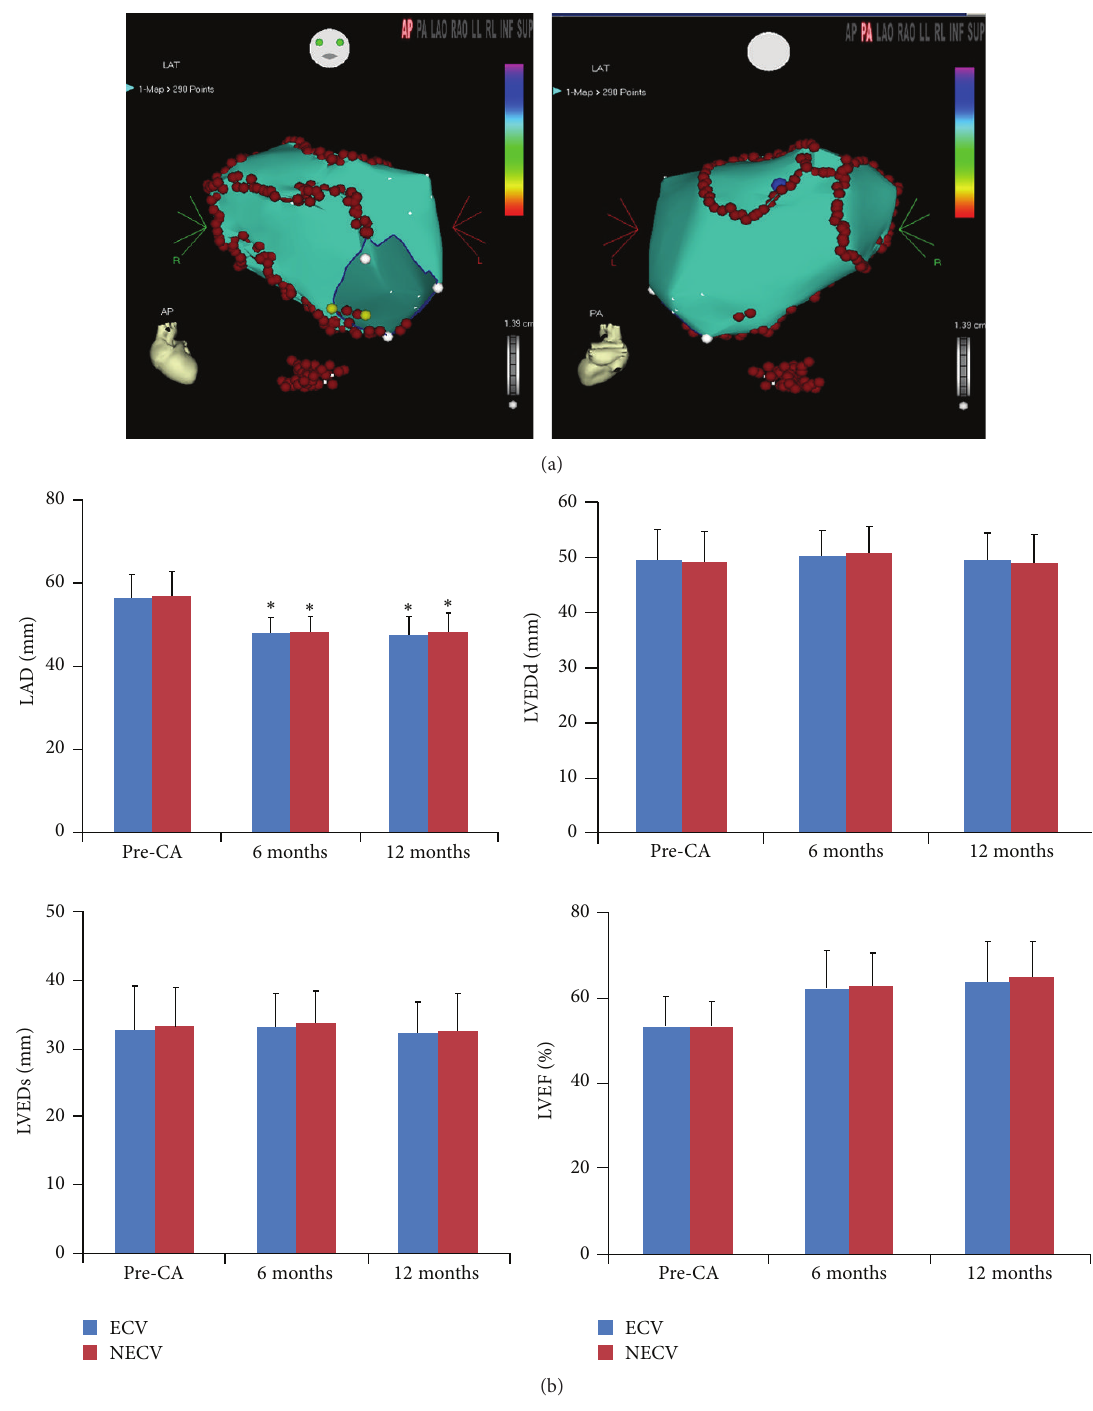
Figure 1: The three-dimensional diagram of catheter ablation persistent atrial fibrillation and myocardial biomarkers. Representative circumferential pulmonary vein isolation and additional ablation line on an electroanatomic map (a). Cardiac function by echocardiography (b). LAD: left atrial diameter. LVEDd: left ventricle diastolic end diameter. LVEDs: left ventricle systolic end diameter. LVEF: left ventricle ejection fraction. ∗ 𝑃 < 0.01 versus pre-CA (before catheter